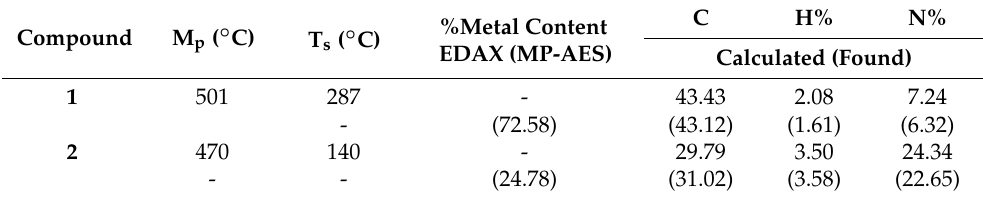
Table 1. Physicochemical properties of [Mn(2,6-pydc) 2 ](imi) ( 1 ) and [Co(H 2 pza) 2 (H 2 O) 2 (NO 3 )] • NO 3 ( 2